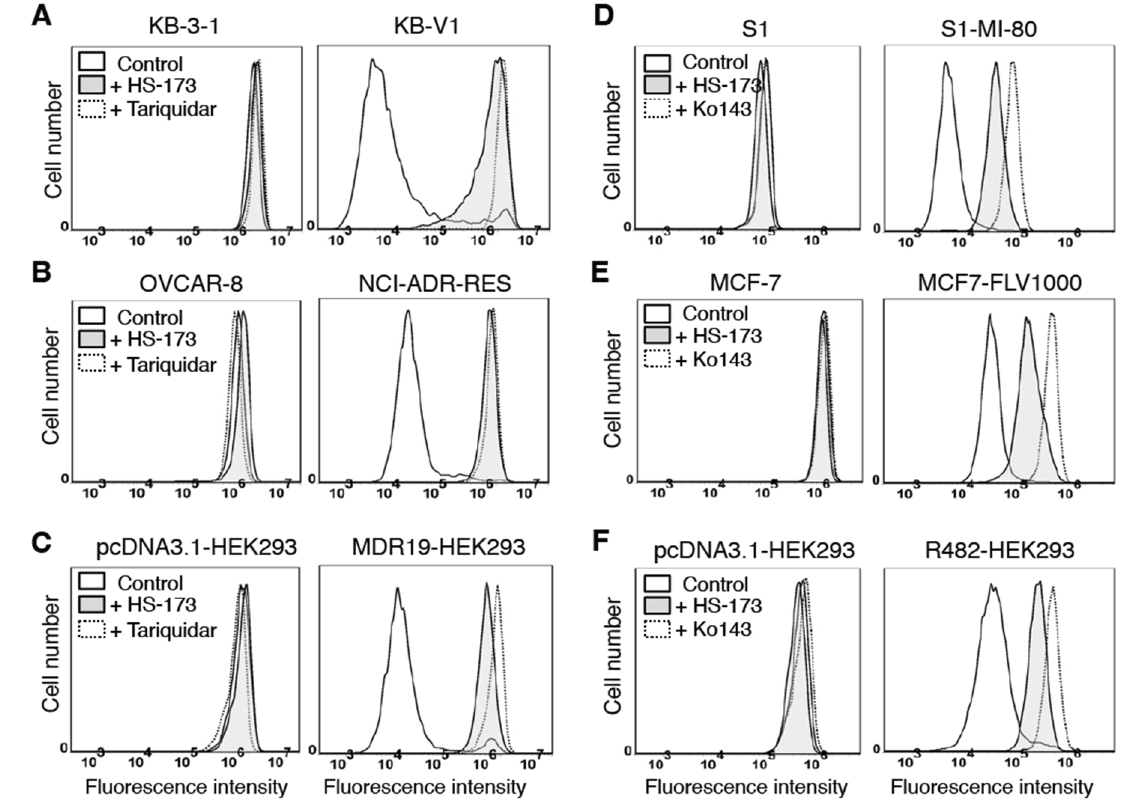
Figure 5. HS-173 inhibits ABCB1- and ABCG2-mediated drug transport. The accumulation of fluorescent calcein in the KB-3-1 cell line ( A , left panel) and its ABCB1-overexpressing KB-V1 line ( A , right panel); OVCAR-8 cell line ( B , left panel) and its ABCB1-overexpressing NCI-ADR-RES ( B , right panel) cells; HEK293 cells stably transfected with the pcDNA3.1 empty vector ( C , left panel) and HEK293 cells stably transfected with human ABCB1 ( C , right panel), or fluorescent pheophorbide A (PhA) in the S1 cell line ( D , left panel) and its ABCG2-overexpressing S1-MI-80 line ( D , right panel); MCF-7 cell line ( E , left panel) and its ABCG2-overexpressing MCF7-FLV1000 line ( E , right panel); HEK293 cells stably transfected with the pcDNA3.1 empty vector ( F , left panel) and HEK293 cells stably transfected with human ABCG2 ( F , right panel), measured without (solid lines) or with the addition of 40 µM HS-173 (shaded, solid lines) or 1 µM tariquidar or Ko143 (dotted lines) and analyzed immediately by means of flow cytometry, as described in the Materials and Methods section. Representative histograms of three independent experiments are shown.